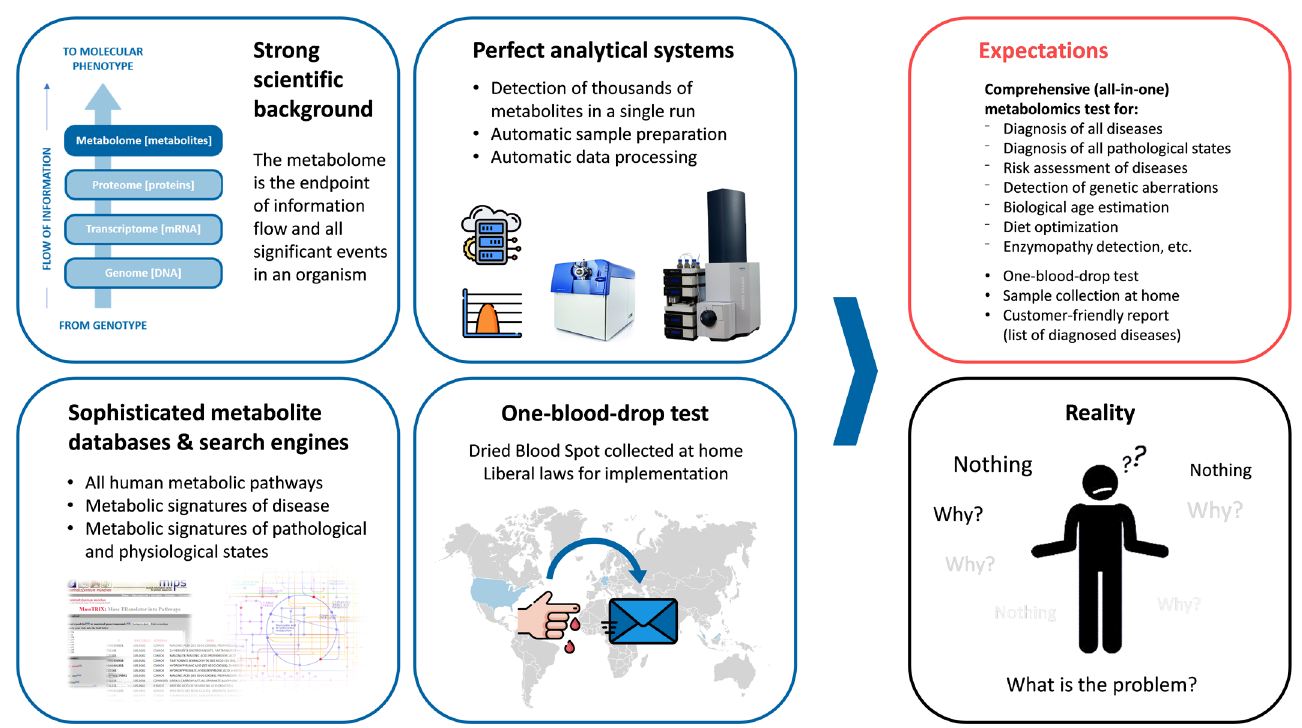
Figure 1. The mystery of translating metabolomics into personalized analysis.